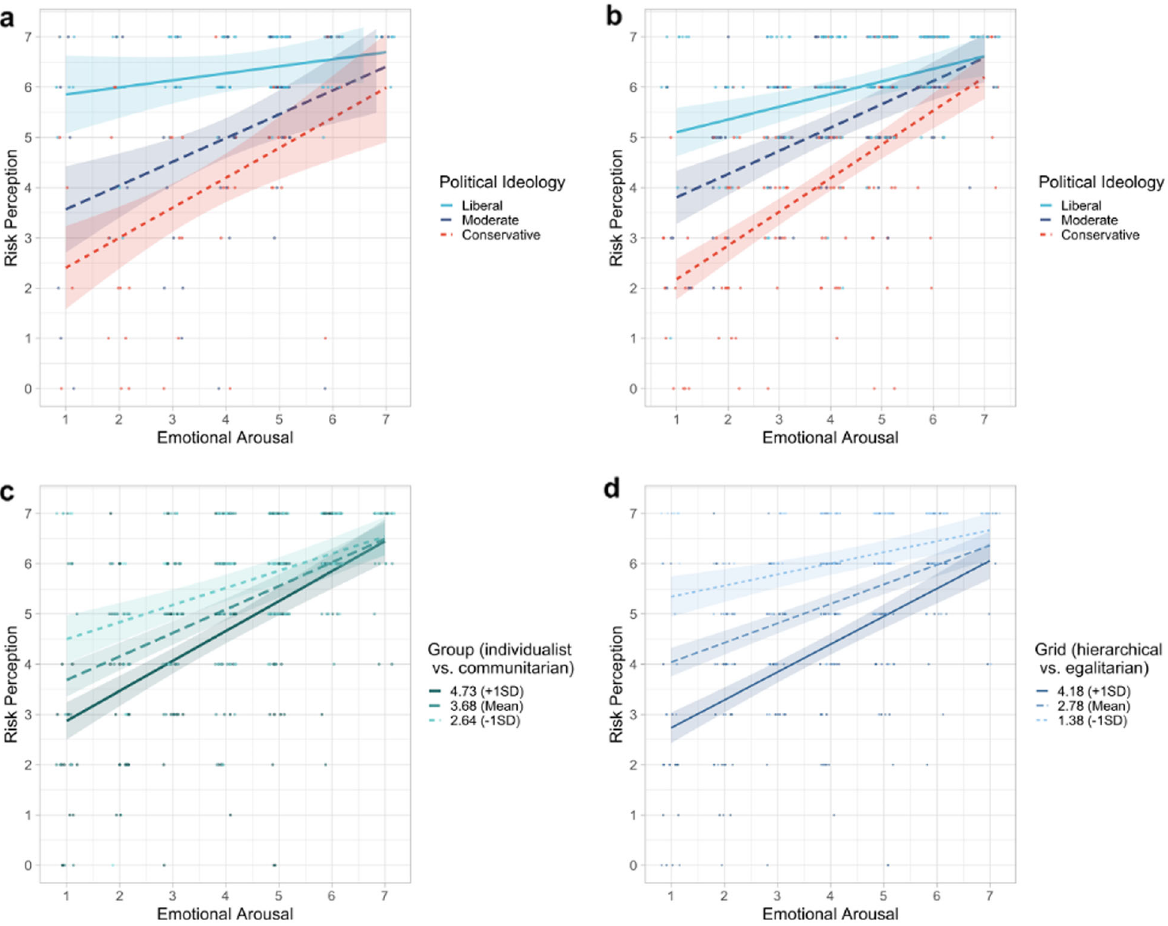
Fig. 1 Interaction effects. Graph ( a ): Study 1, interaction between risk perception and emotional arousal across moderator levels (political ideology: liberal, moderate, conservative). Graph ( b ): Study 2, interaction between risk perception and emotional arousal across moderator levels (political ideology: liberal, moderate, conservative). Graph ( c ): Study 3, interaction between risk perception and emotional arousal across moderator levels (Group cultural worldviews: individualists, communitarians). Graph ( d ): Study 3, interaction between risk perception and emotional arousal across moderator (Grid cultural worldviews: hierarchical,